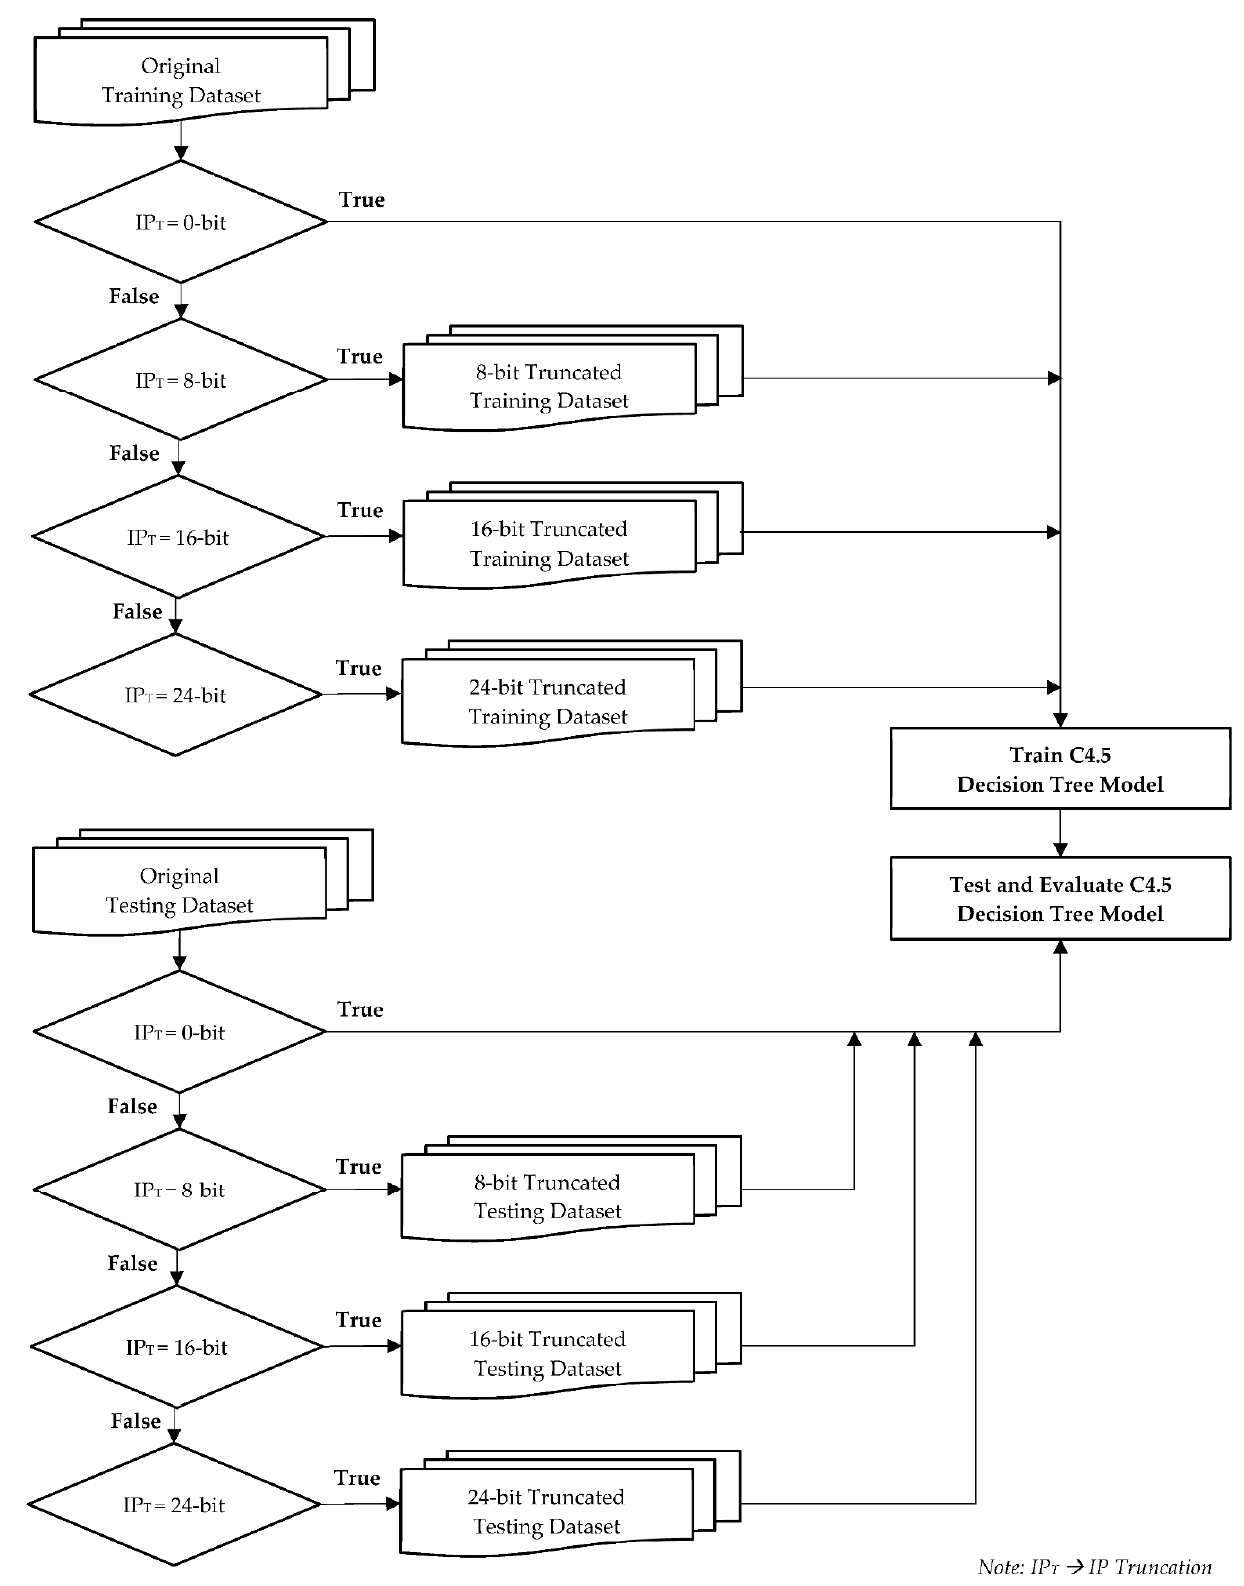
Figure 3. Methodology Diagram of the Proposed IP Truncation Pruning Algorithm.